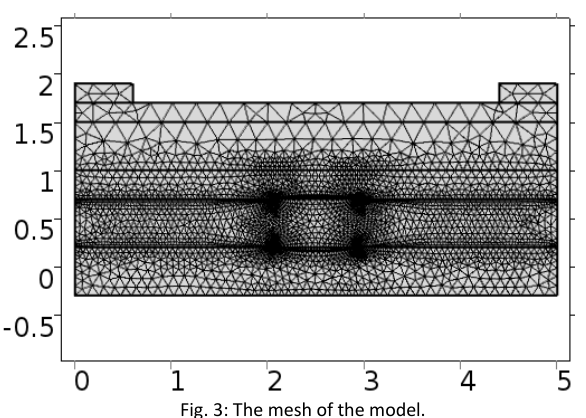
Fig. 3: The mesh of the model.